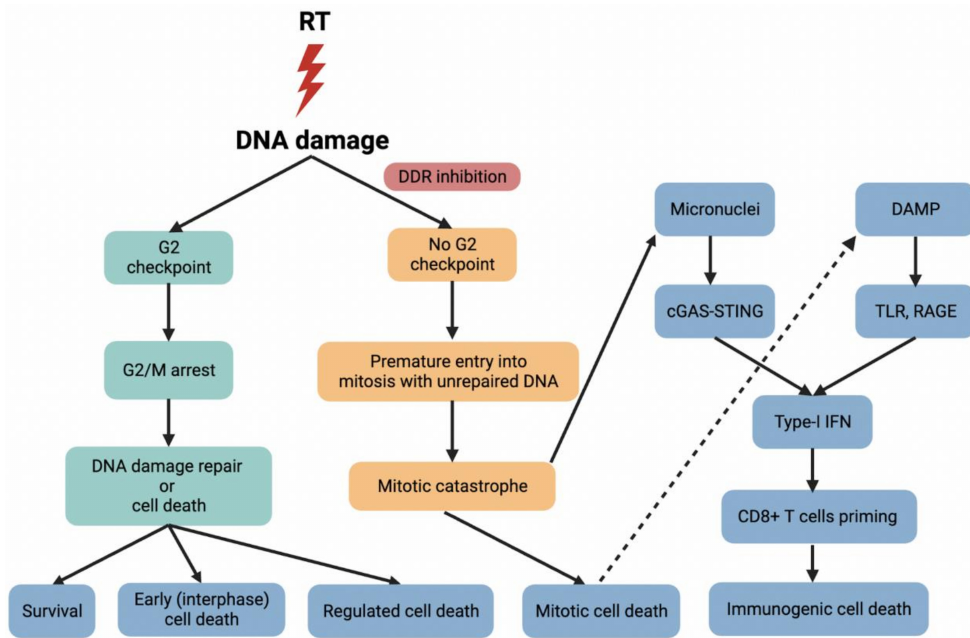
Figure 2. Radiotherapy (RT) causes DNA damage, and DDR inhibitors selectively mediate G2 check- point inhibition, allowing cells with unrepaired DNA to prematurely enter into mitosis, ultimately leading to mitotic catastrophe. DNA damage induces the release of damage-associated molecular pattern (DAMP) molecules. For example, HMGB1 is released into the extracellular environment and then mediates potent pro-inflammatory effects by binding to its downstream receptors such as Toll-like receptors (TLR) and receptors for advanced glycation end products (RAGE) to stimulate efficient processing and cross-presentation of tumor antigens from dying cells. Naive T cells differ- entiate into tumor-specific CD8+ T cells in response to type I interferon (IFN), leading to activation inhibition and mitotic death contribute to the formation of micronuclei, which is detected by cyclic GMP-AMP synthase (cGAS) and stimulate production of type I IFN as well as other